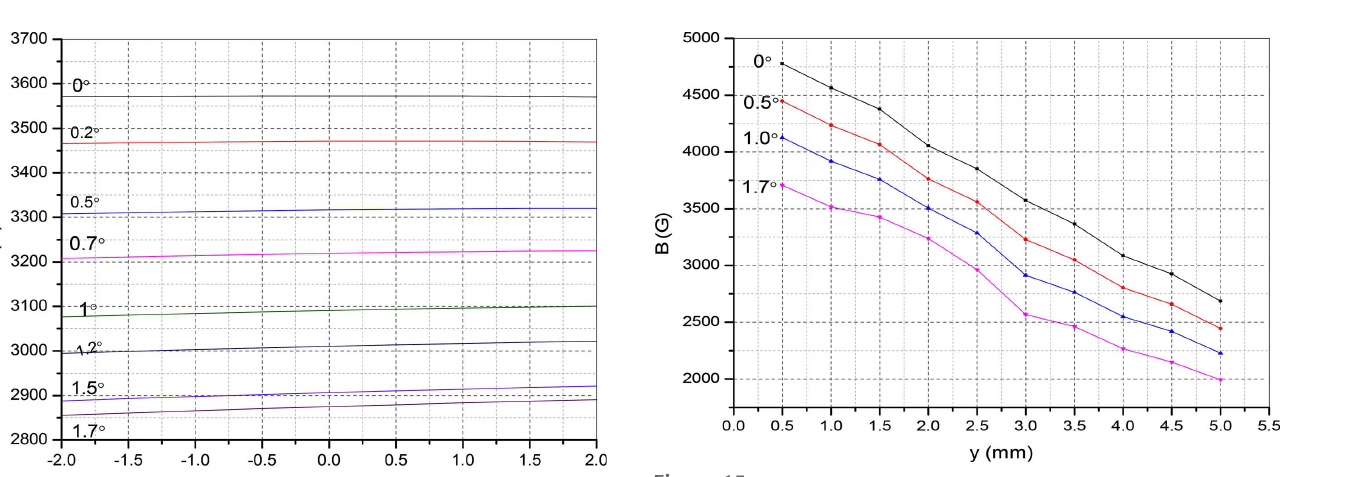
Figure 15 Effects of the tilt on the vertical field with distance away from the probe.